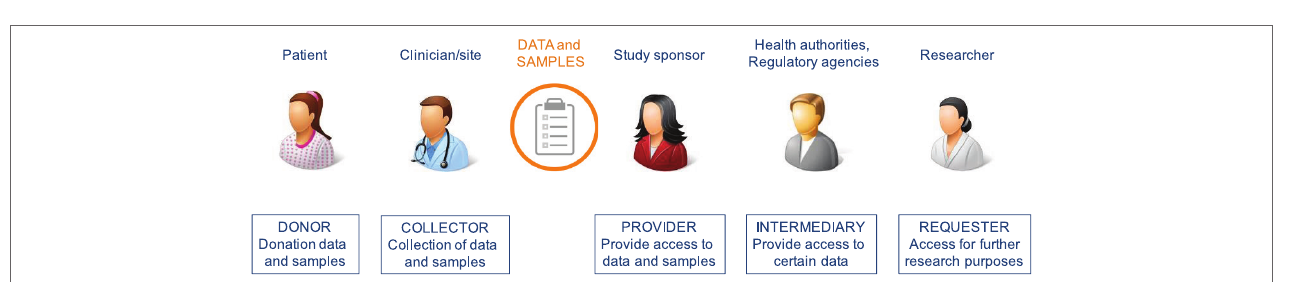
FigUre 1 | Chain of stakeholders involved in the process of sharing of clinical patient data and samples.